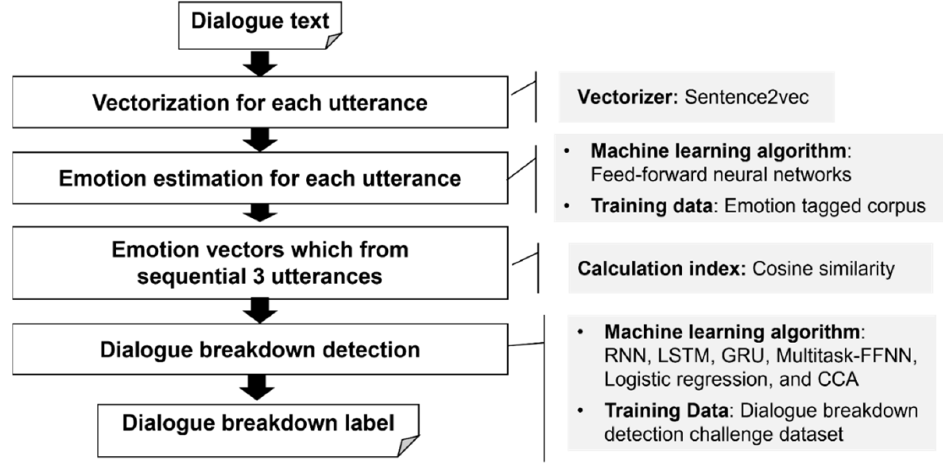
Figure 1. Flow of proposed method.